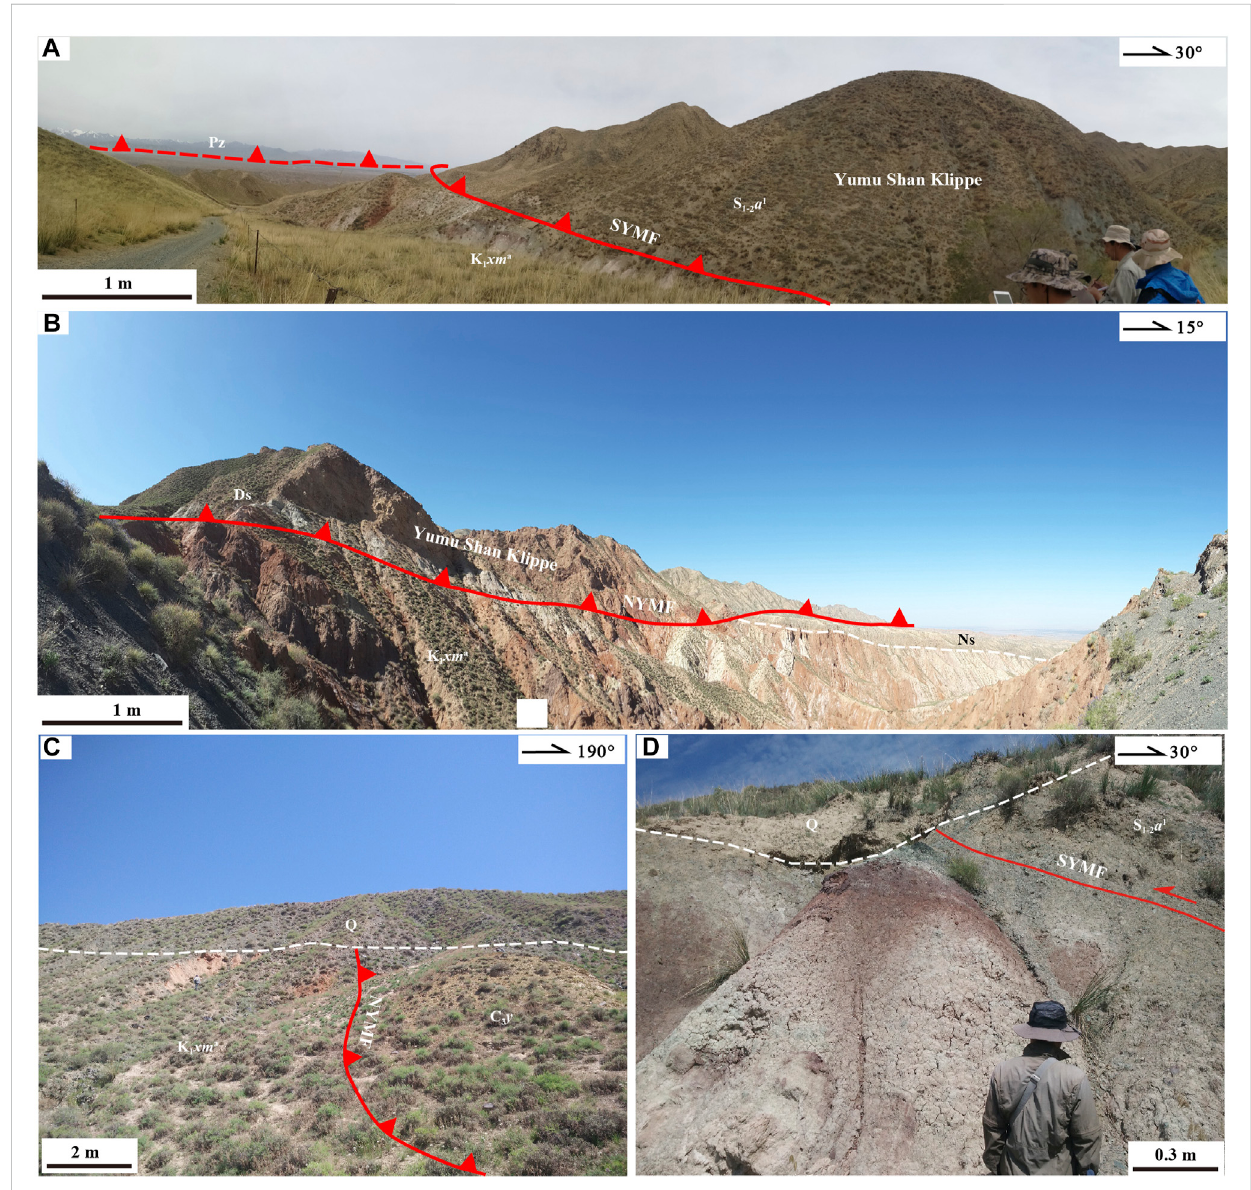
FIGURE 4 Field photographs from the Yumu Shan region, displaying contacts between the Lower Cretaceous (K 1 ) and overlying sequences. Photograph locations are shown inFigure 3. (A) SYMF placingtheSiluriansystem(S 1-2 )overtheLower Cretaceous strata (K 1 ).Pz, Paleozoic stratain north Qilian Shan. (B) NYMFplacingtheSiluriansystem(S 1-2 )overtheLowerCretaceousstrata(K 1 )andunconformablycoveredbyNeogenestrata(N). (C) NYMFplacingthe Carboniferous strata (C 3 ) over the Lower Cretaceous strata (K 1 ) and unconformably covered by Quaternary strata (Q). (D) SYMF placing the Silurian system (S 1-2 ) over the Lower Cretaceous strata (K 1 ) and unconformably covered by Quaternary strata